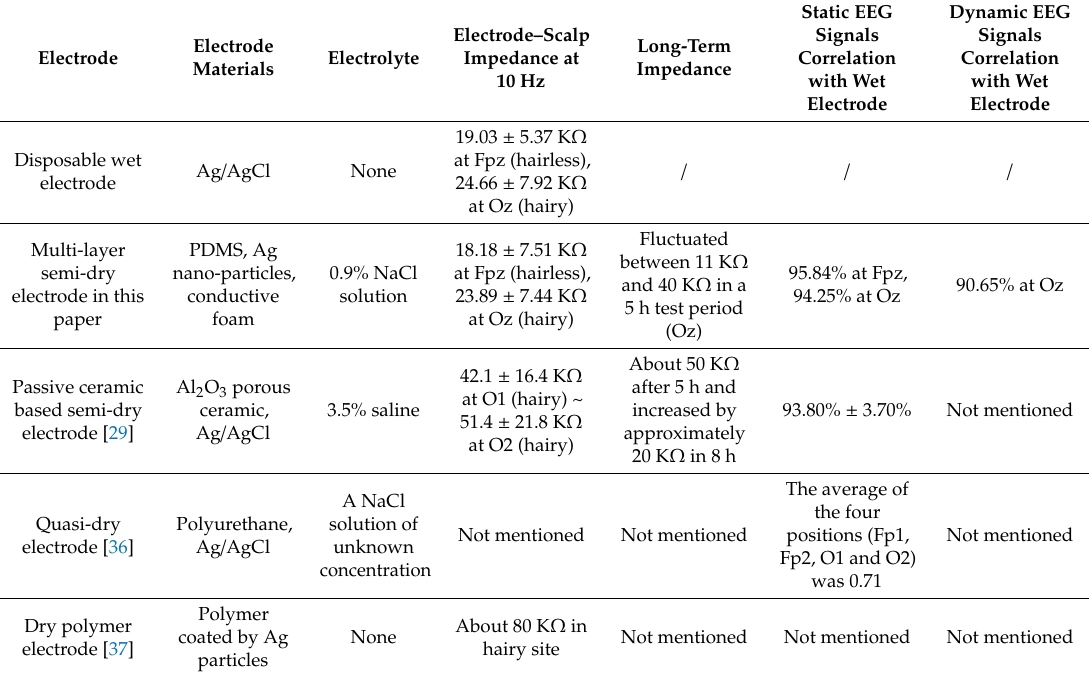
Table 1. Comparison with other